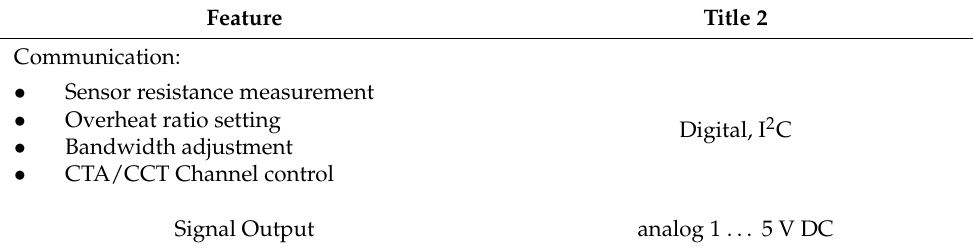
Figure 3. Hot-wire anemometer with automatically adjusted dynamic properties. Table 1. Hot-wire anemometer—specification.